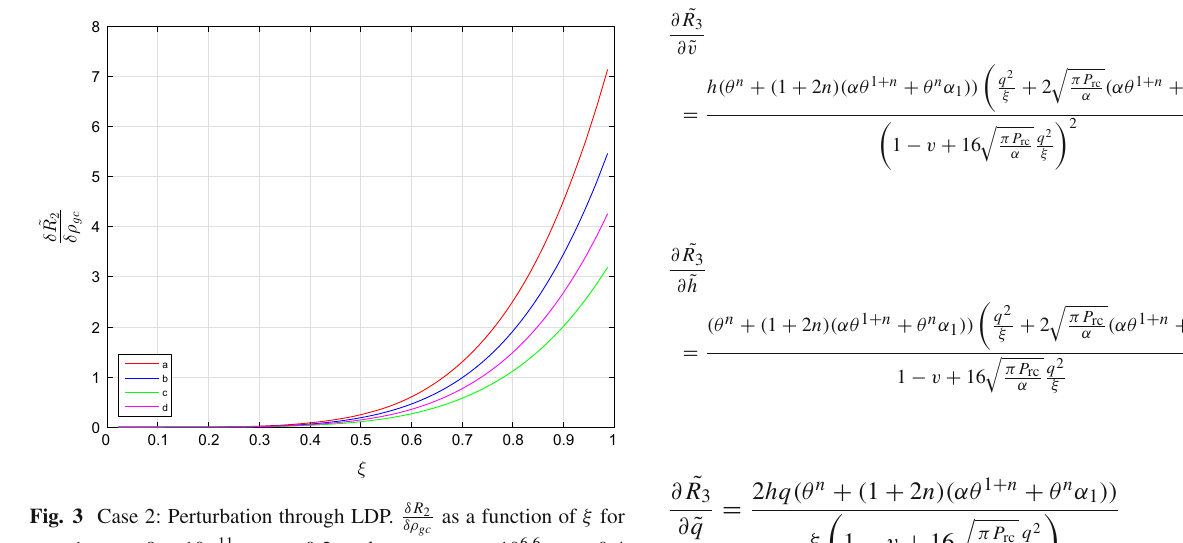
as a function of ξ for gc